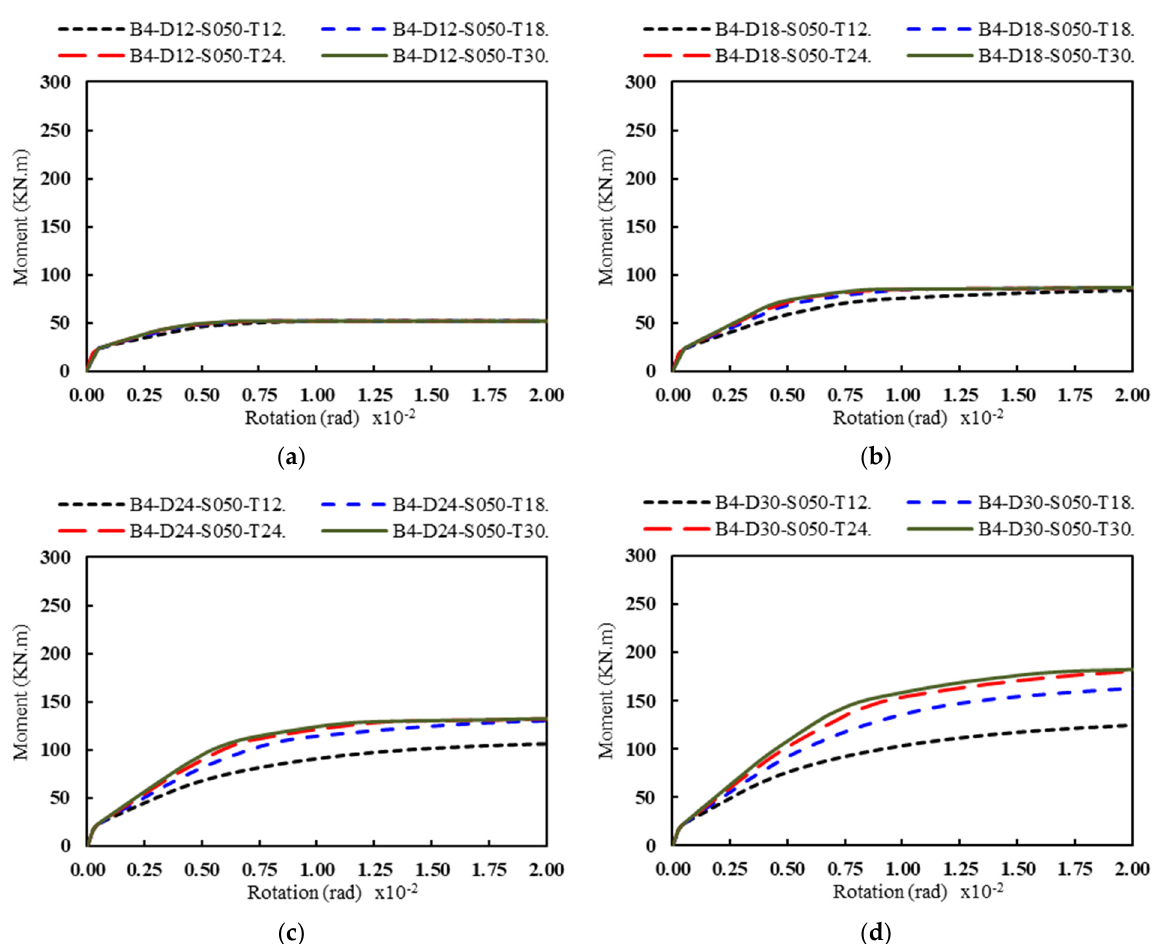
Figure 13. Effect of the base plate thickness (T) on the rotational stiffness for different anchor bolt diameters (D): ( a ) D = 12 mm, ( b ) D = 18 mm, ( c ) D = 24 mm, and ( d ) D = 30 mm (four anchor bolts and S = 50 mm).